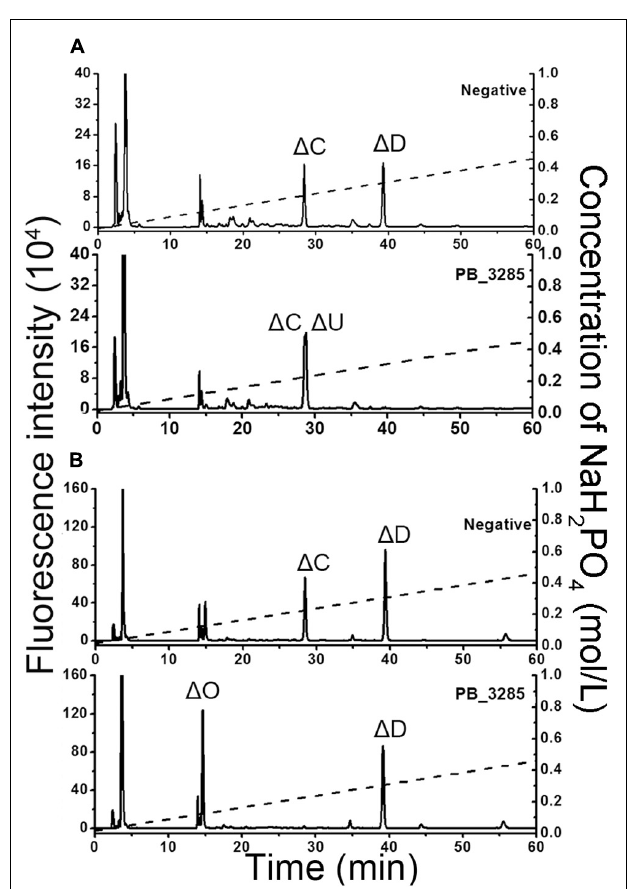
FIGURE 6 | under the same conditions. The resultants were digested with CSase ABC and labeled with 2-AB for disaccharide analysis by anion-exchange HPLC as mentioned above. The elution positions of the standard disaccharides are indicated: (cid:49) O ( (cid:49) HexUA1–3GalNAc), (cid:49) A [ (cid:49) HexUA1–3GalNAc(4S)], (cid:49) C [ (cid:49) HexUA1–3GalNAc(6S)], (cid:49) D [ (cid:49) HexUA(2S)1–3GalNAc(6S)], (cid:49) E [ (cid:49) HexUA1–3GalNAc(4S,6S)] and (cid:49) U [ (cid:49) HexUA(2S) 1–3GalNAc]. The peaks detected around 3 min in the figures are derived from fluorescent labeling reagents.